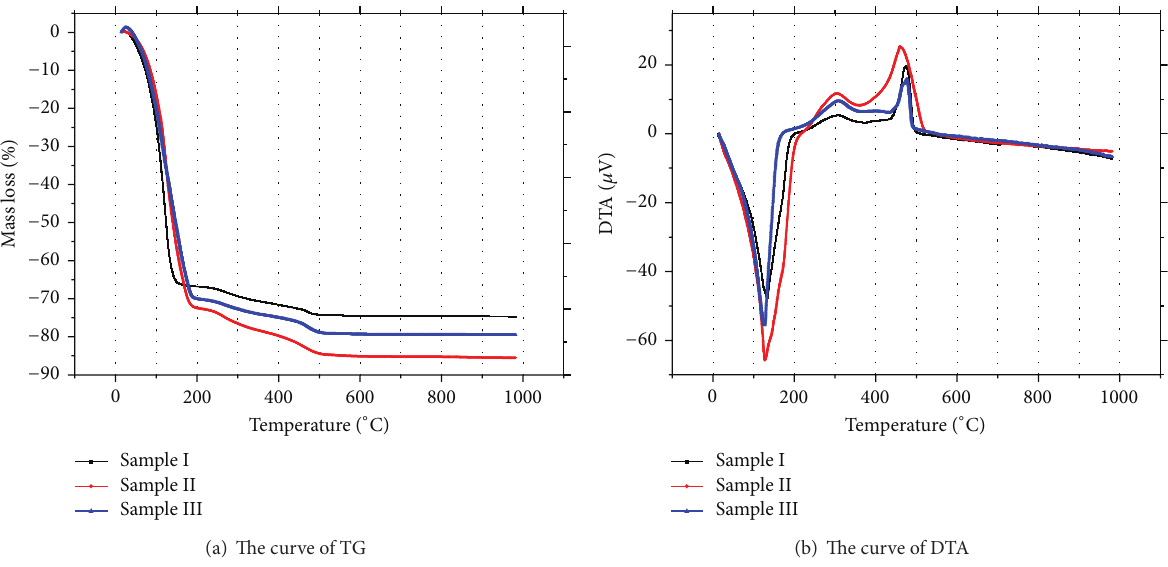
Figure 11: The curve of the thermal effect at 28th day of the